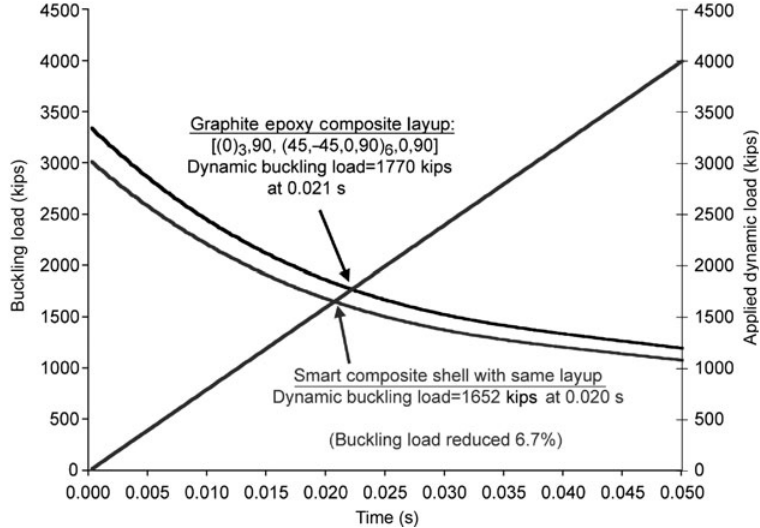
Figure 13 Dynamic buckling load of a smart composite shell with 0 ° and 90 ° graphite fi bers in plies 1 and 30. (1 kip = 4.45